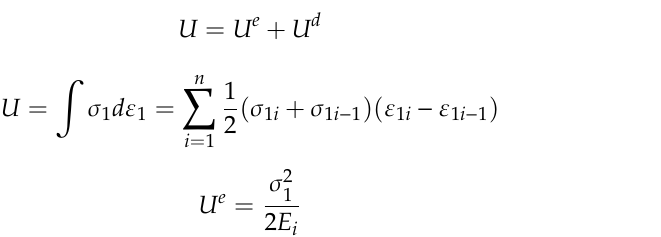
Figure 4. Sample placement and compression.